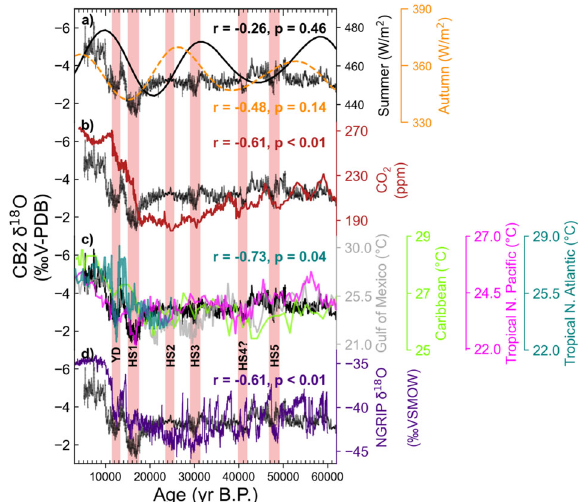
Fig. 3 | Comparison of CB2 δ 18 O to various potential forcings. a Autumn (SON, r = − 0.48, p <0.14, orange) and Summer (JJA, r = − 0.26 p =0.46 black) insolation. b Atmospheric pCO 2 ( r = − 0.61, p <0.01, maroon 109 ). c SSTs from Gulf of Mexico ( r = − 0.52, p <0.03, silver 59 ), Caribbean ( r = − 0.59, p <0.05, lime green 58 ),